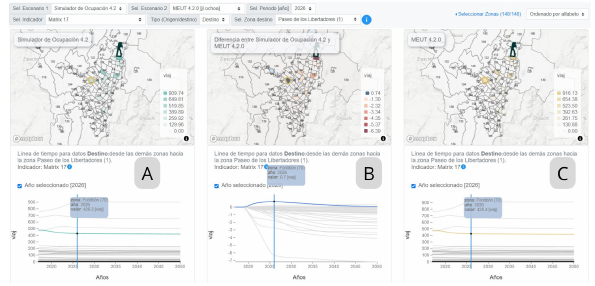
In Figure 4: Inter-zone comparator explorer tool: (A) Map with colorphlet map focused on the selected period data. The Origin zone is highlighted, line graph with one line per zone for the selected zone with the“inter-zone” indicator (origin to destina- tion) with the selected period highlighted in a specific simula- tion (B)Map and line graph that show the difference between the first scenario”A” and the second scenario”C”. (C) Map and line graph focused on the selected period data ,selected”inter- zone” indicator in a specific simulation.